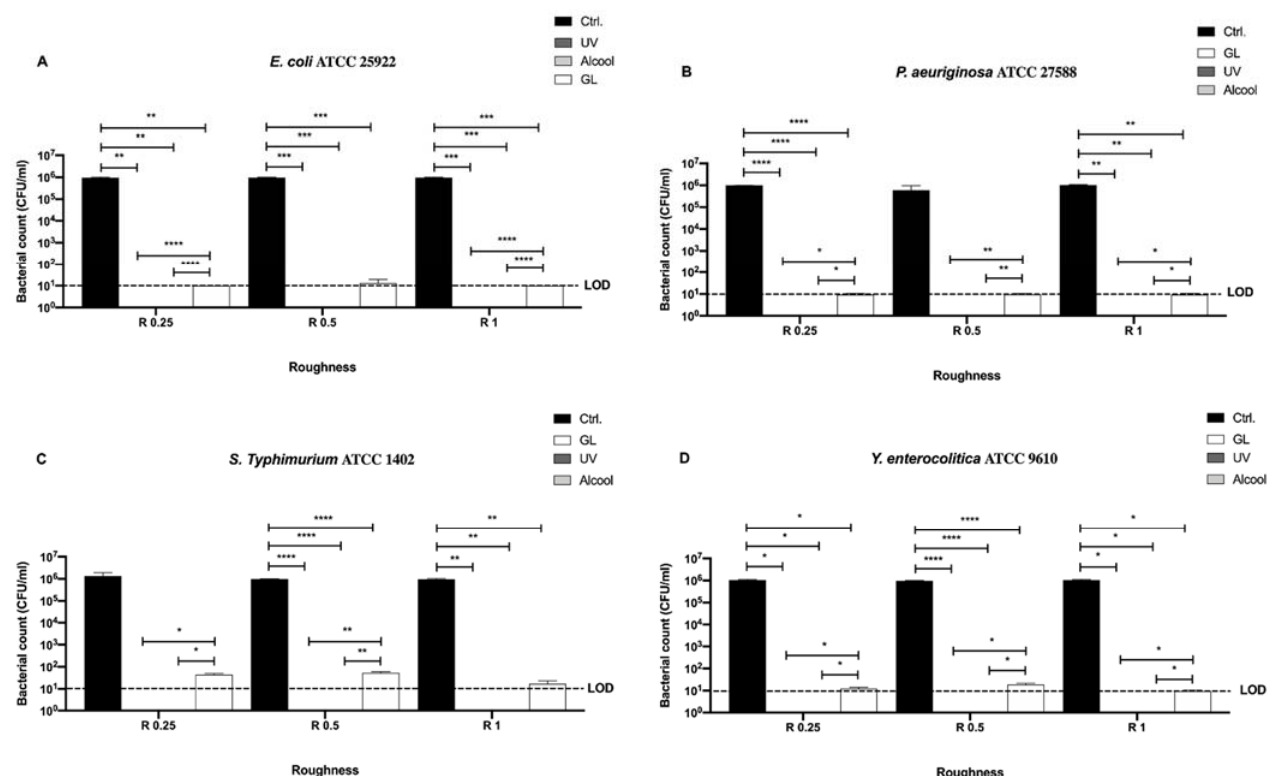
Figure 5. Graphical representation of the antibacterial activity of UV, alcohol 70% v/v and GL against Gram-negative bacteria ( A–D ) at different AISI 316 stainless steel surface roughness, **** p < 0.0001, *** p < 0.001, ** p < 0.01, * p < 0.05; Limit of detection (LOD) is 10 1 (10E+1).